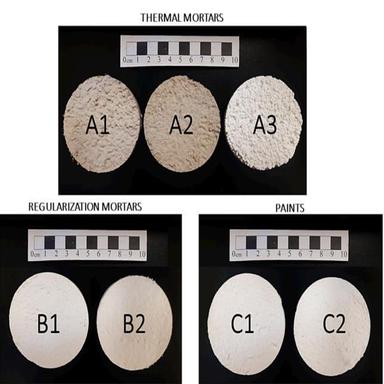
Materials considered in the study. Two thermal mortars with hydraulic lime and cork-aggregates (A1, A2), and one with mixed binders and EPSaggregates (A3). Two regularization mortars, one based on air lime (B1) and one based on mixed hydraulic binders (B2). A lime-paint (C1) and a potassium silicate paint (C2).